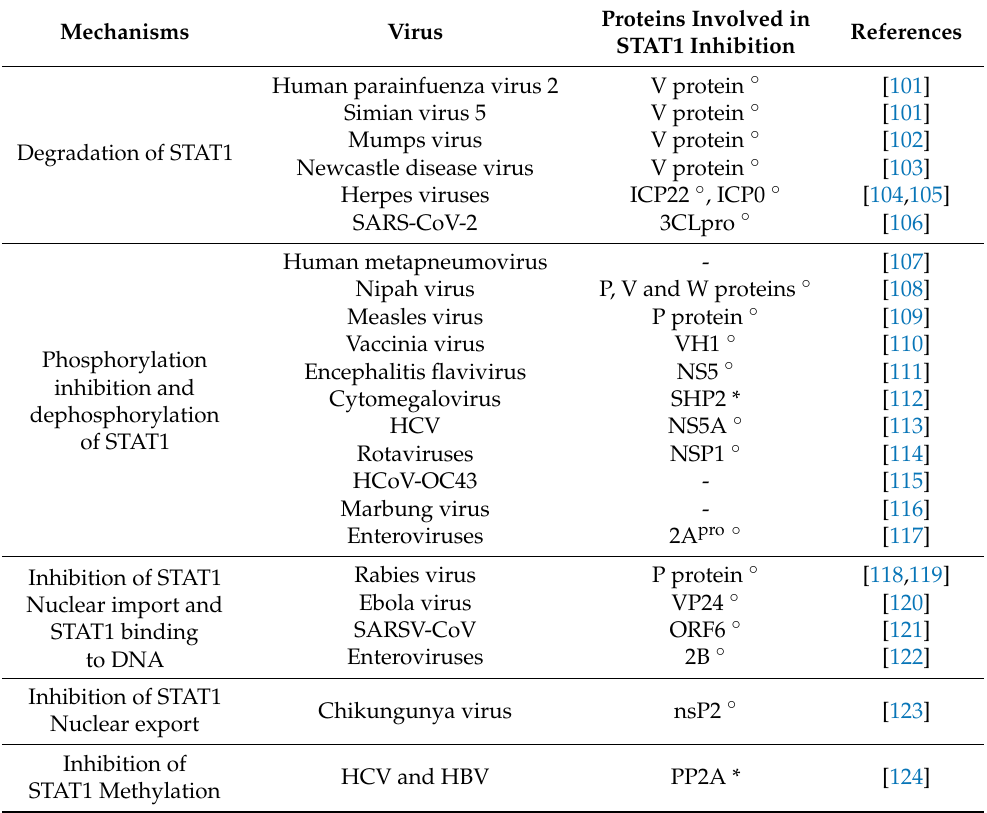
Table 1. Mechanisms by which viruses block the STAT1